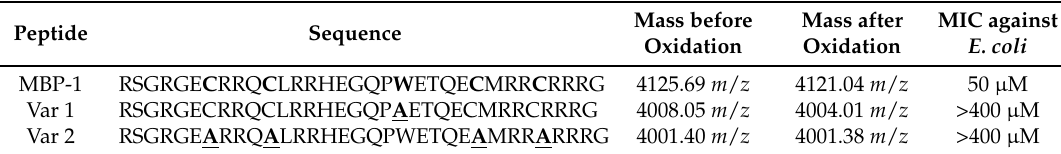
Table 1. Sequences, masses before and after oxidation and MIC of MBP-1 and its variants. Mutated residues are underlined in the sequence. Mass/charge relation before and after oxidation was checked by MALDI.